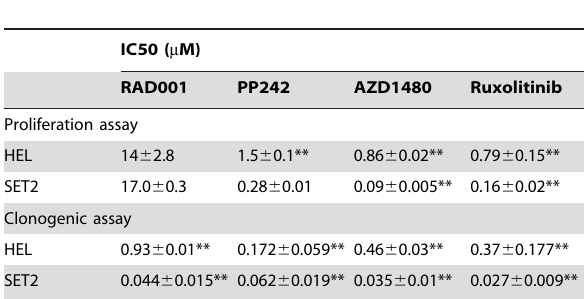
Table 1. Effects of mTOR (RAD001 and PP242) and JAK2 (Ruxolitinib and AZD1480) inhibitors on the proliferation rate and clonogenic growth of human JAK2 V617F mutated cell